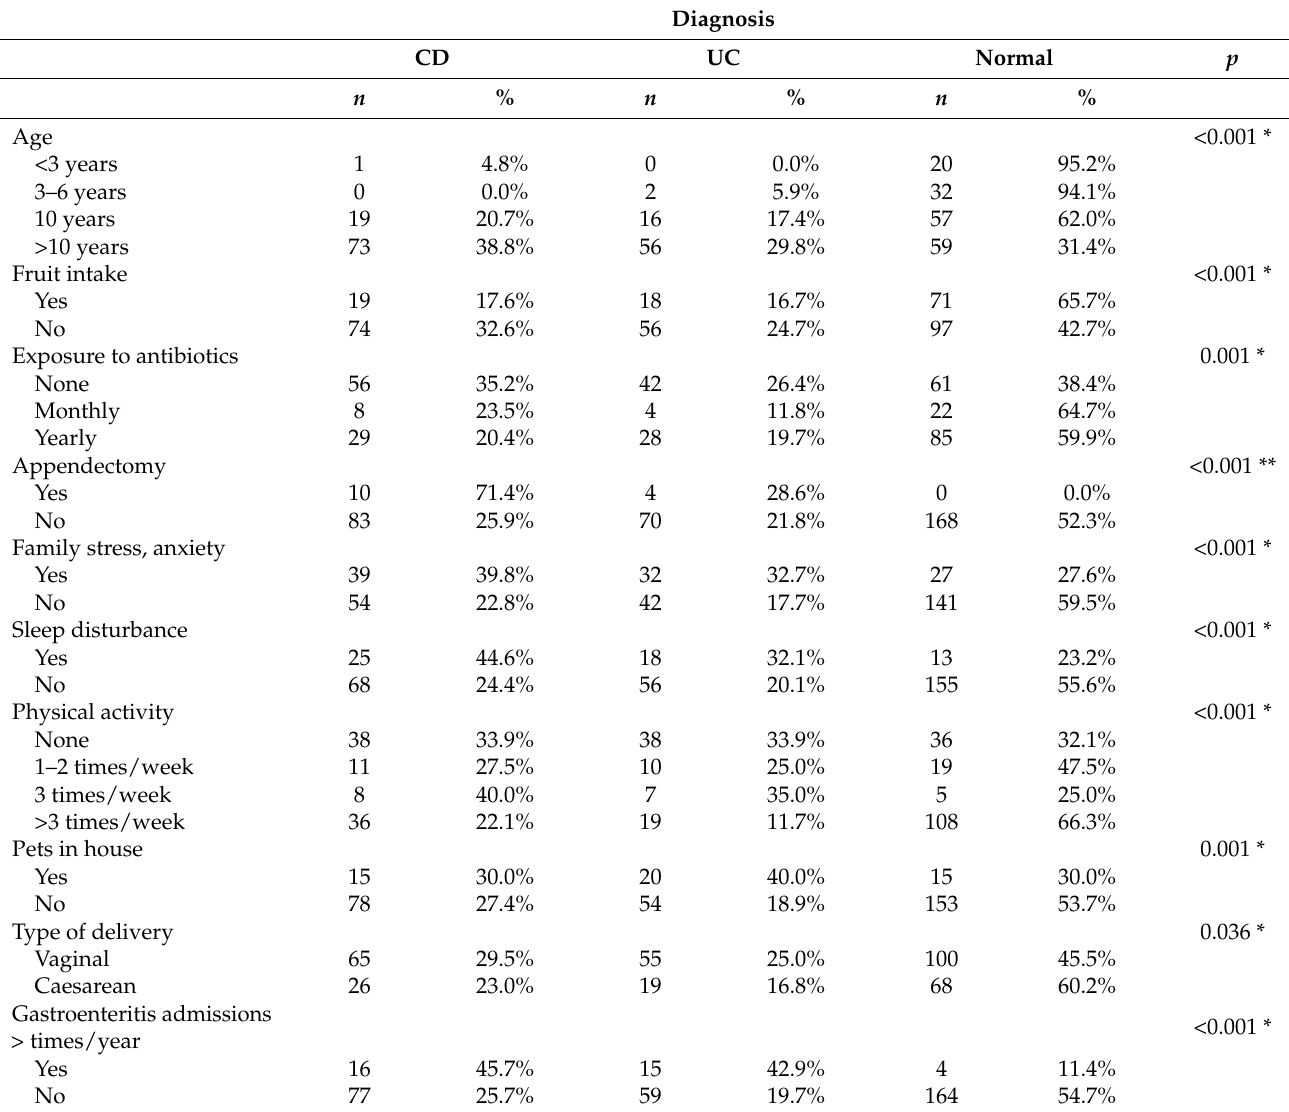
Table 4. Difference between CD and UC according to risk